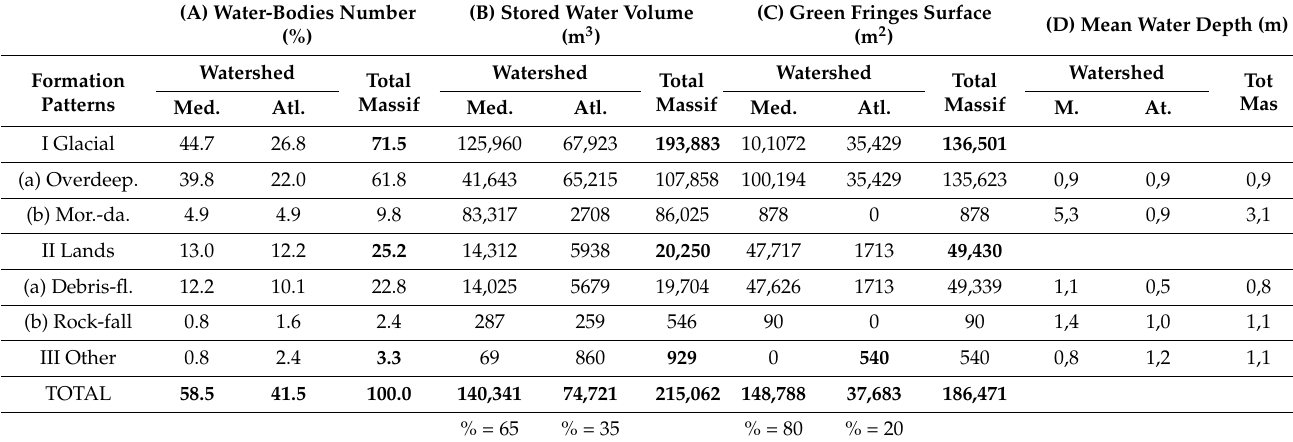
Figure 8. Specific cases of the different formation models according to the sketches of Figure 6: these oblique aerial views were obtained from Google Earth. The arrows point to small water-bodies. ( A ) Laguna de la Mosca (tarn) at the foot of the Mulhac é n peak. ( B ) El Caballo moraine-dammed lake. ( C ) La Mula water-body caused by a landslide. The asterisk shows an overlapping landslide front over a meadow (yellowish colour). Observe the deep weathering of the substratum. ( D ) Laguna de los Ge ó logos showing the typical whitish sediments of the bottom of a water-body. This water-body is located at the end of two heterometric masses of rocks: the closer one, light grey in colour, contains abundant fine material, while the upper mass (dark colour) is mainly formed by rocky blocks. Table 1. Main characteristics related to the different categories of water-bodies in Sierra